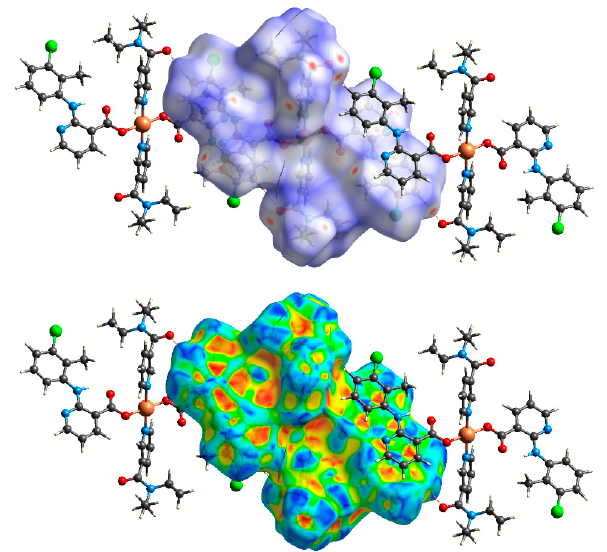
Figure 3. View of the 3D Hirshfeld surface of 4 plotted over d norm in the range of − 0.2000 to 1.4950 a.u. (top) and shape index (bottom).